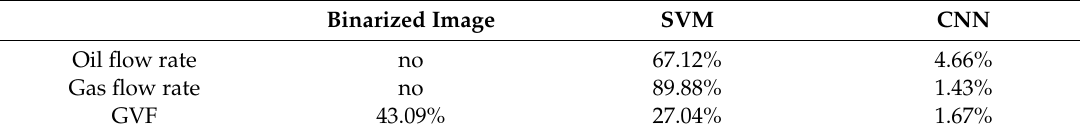
Table 4. Average relative error table of prediction of Mixed data before and after the venturi